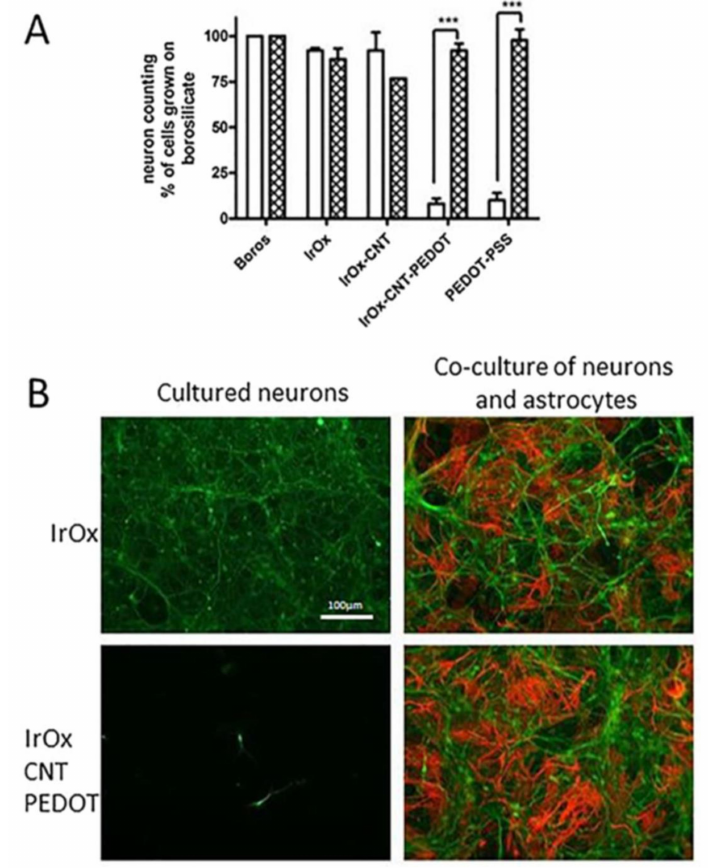
Figure 10. Neuronal survival and functionality on IrO x -eG. Representative fluorescent microphotographs of neurons growing on: ( A ) Borosilicate glass, ( B ) IrO x , ( C ) IrOx-eG and ( D ) Platinum, stained against Tau (red) and NeuN (green) showing dendrites and living cell nucleii. Scale bar = 100 µ m [24]. With permission from Elsevier.